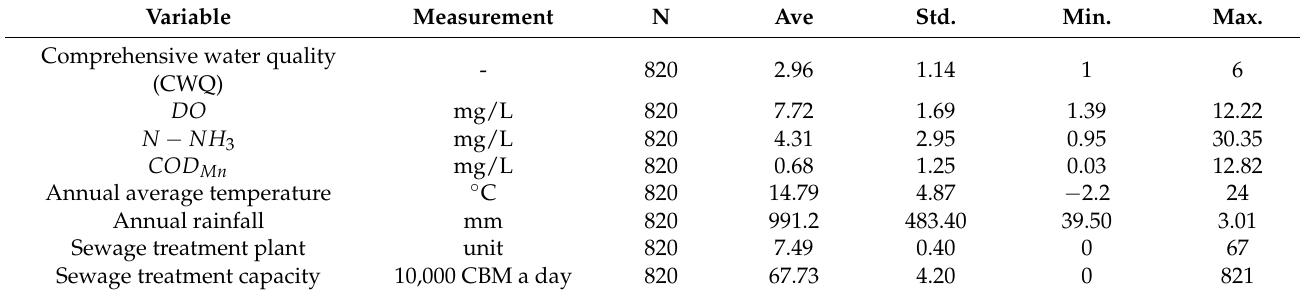
Table 2. Descriptive statistics of variables (annual data).